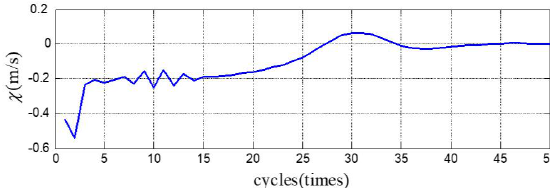
Figure 7. Values of the state jumps measure (60) of the one-legged